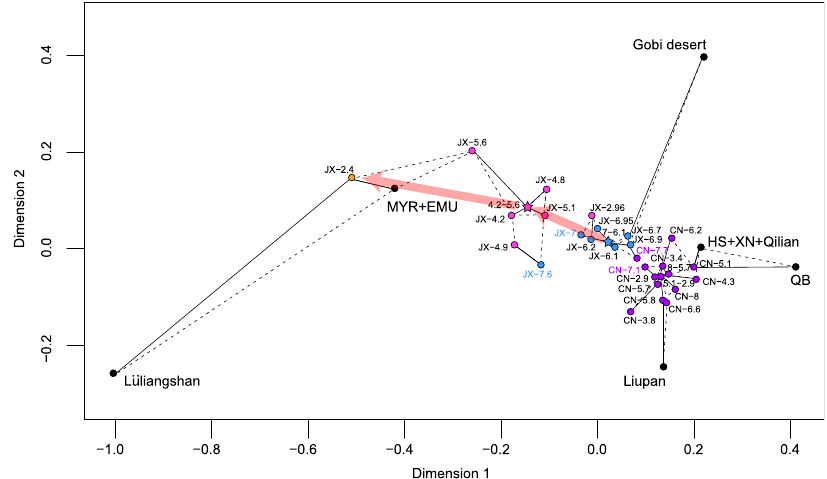
Fig. 4 Nonparametric multi-dimensional scaling (MDS) plot of zircon U-Pb age data of the loess and Red Clay sequences on the CLP and comparison with potential sources. Blue, pink, and orange dots represent late Miocene Red Clay, Pliocene Red Clay, and loess samples from the JX site, respectively. The pink and blue stars represent all 5.6 – 4.2 Ma samples and all 7 – 6.1 Ma samples, respectively. Purple dots are the Red Clay samples from the CN site of different ages (numbers indicate ages in Ma). Black dots are potential source areas. Solid lines mark the closest neighbors and dashed lines link the second closest neighbors. JX Jiaxian, CN Chaona, HS, Huangshui River sediment, XN Xining Basin sediment, QB Qaidam Basin sediment, MYR Middle Yellow River sediment, EMU Eastern Mu Us Desert. Two red arrows show the stepwise increased spatial provenance contrast on the CLP.